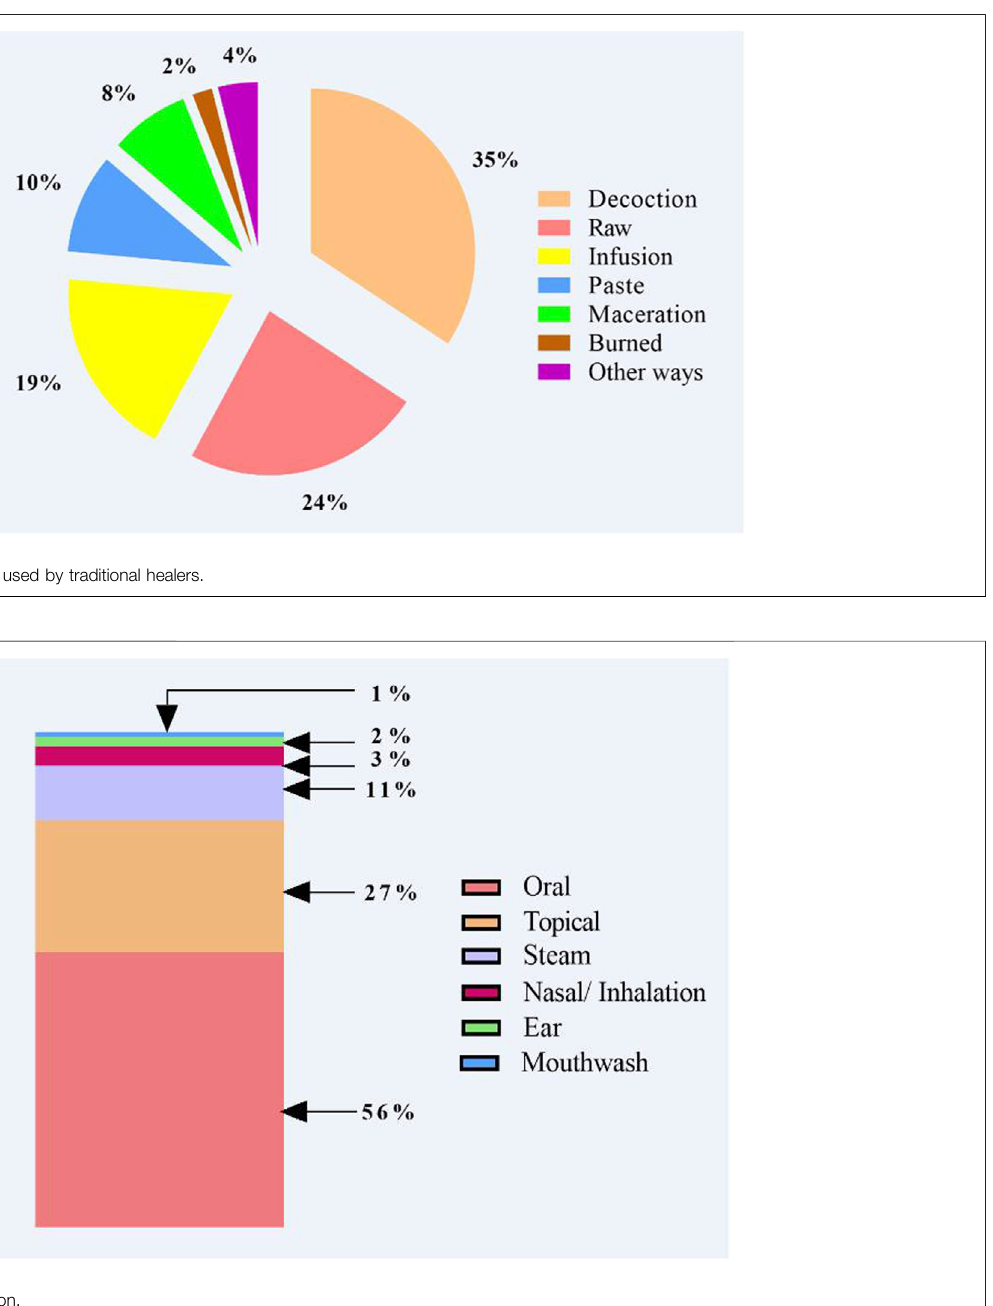
FIGURE 5 | Modes of